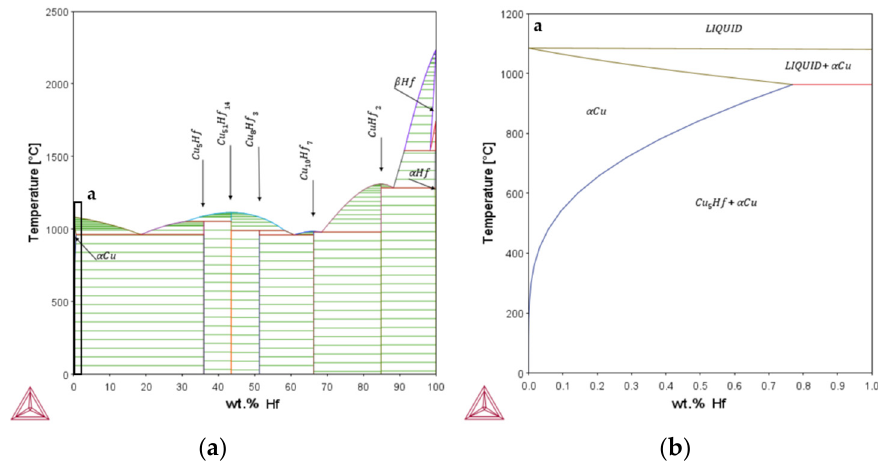
Figure A2. System Cu-Sc: ( a ) overall; ( b ) magnification of the copper-rich area (detail a) [26].